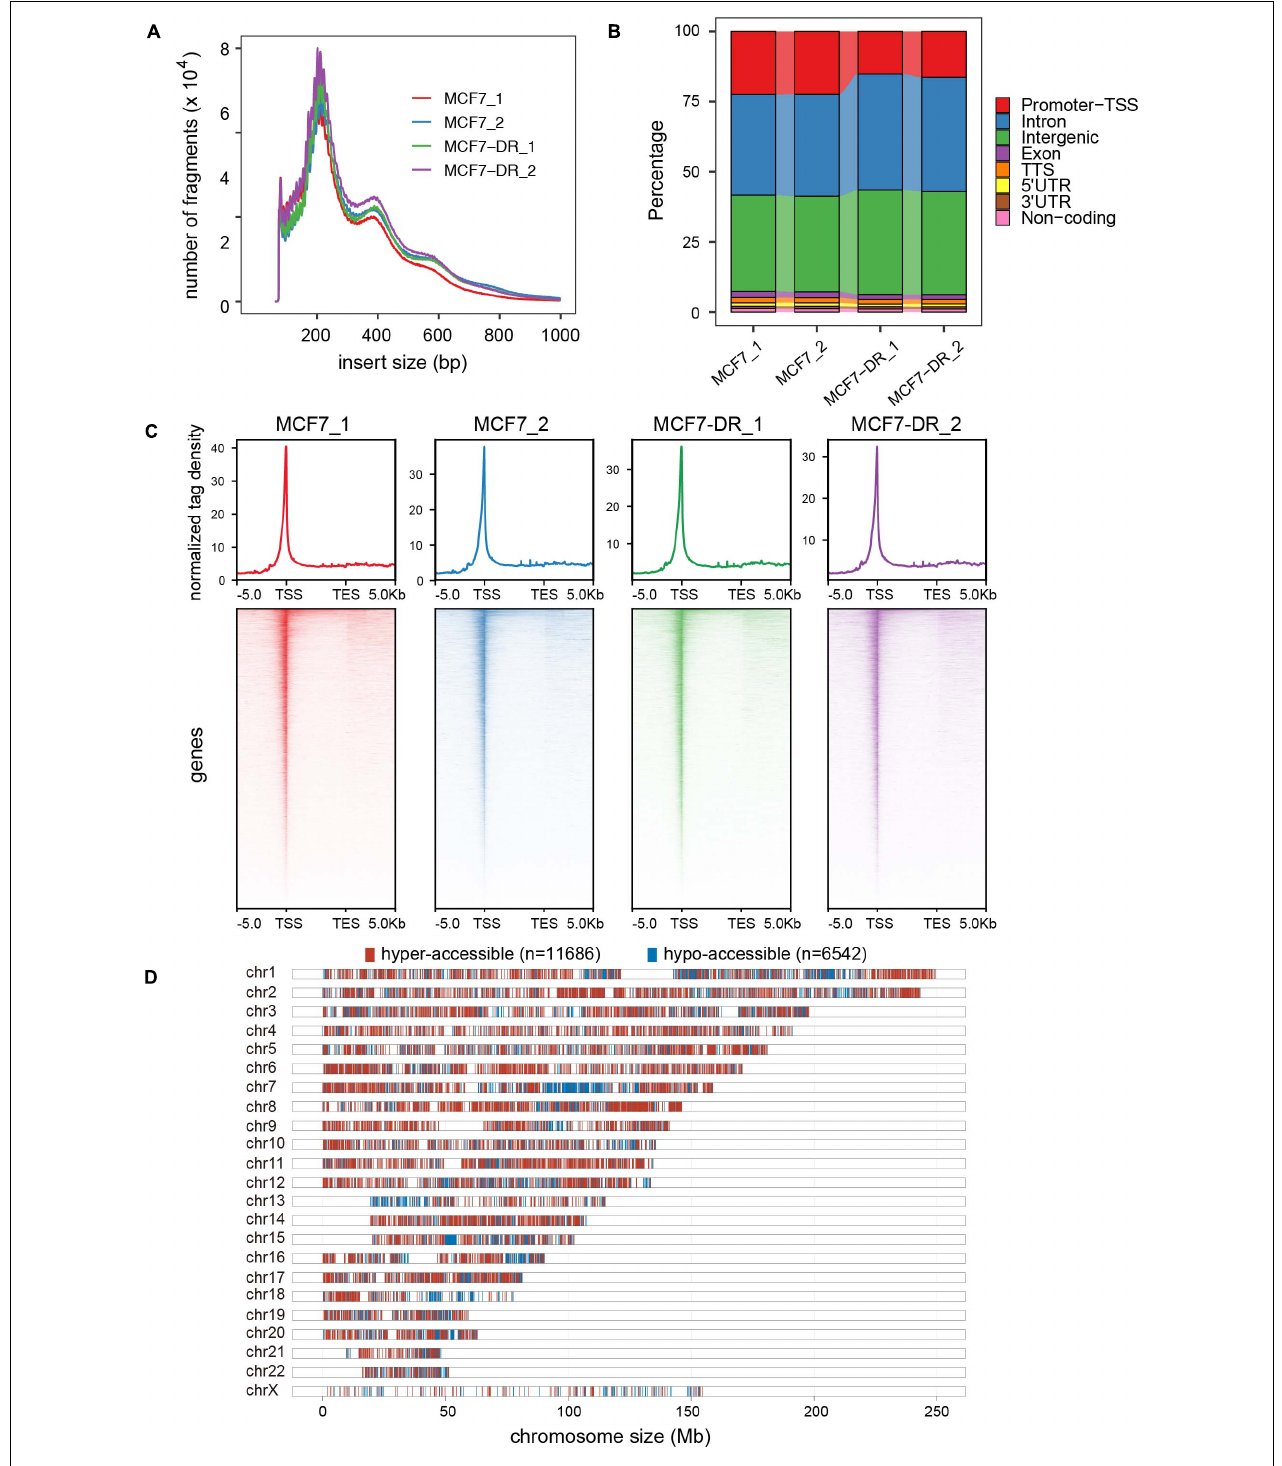
FIGURE 2 | Genome-wide landscape of chromatin accessibility in MCF7 and MCF7-DR cells. (A) Distribution of ATAC-seq fragment size in each sample. Clear modulation of signal is evident for mono-, di- and tri-nucleosomes. (B) Annotation of ATAC-seq peaks to genomic features: exon, intergenic regions, introns, 3 (cid:48) UTR, 5 (cid:48) UTR, promoters-TSS, TES and no-coding regions. Peak summit located within upstream –1,000 bp to + 100 bp downstream of the TSS is determined to be “promoter-TSS.” (C) The average read density (top) and heatmaps (bottom) indicating ATAC-seq signal across a genomic window of upstream –5 Kb to +5 Kb downstream of the TES. (D) Distribution of hyper- (red) and hypo-accessible (blue) regions over chromosomes in MCF7-DR cells compared to MCF7.